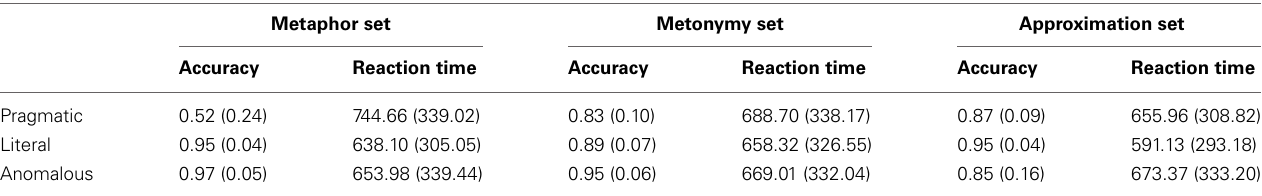
Table 3 | Accuracy rates and mean reaction times (ms) for correct responses as a function of pragmatic modulation (pragmatic, literal, anomalous conditions) and set type (Metaphor set, Metonymy set, Approximation set).